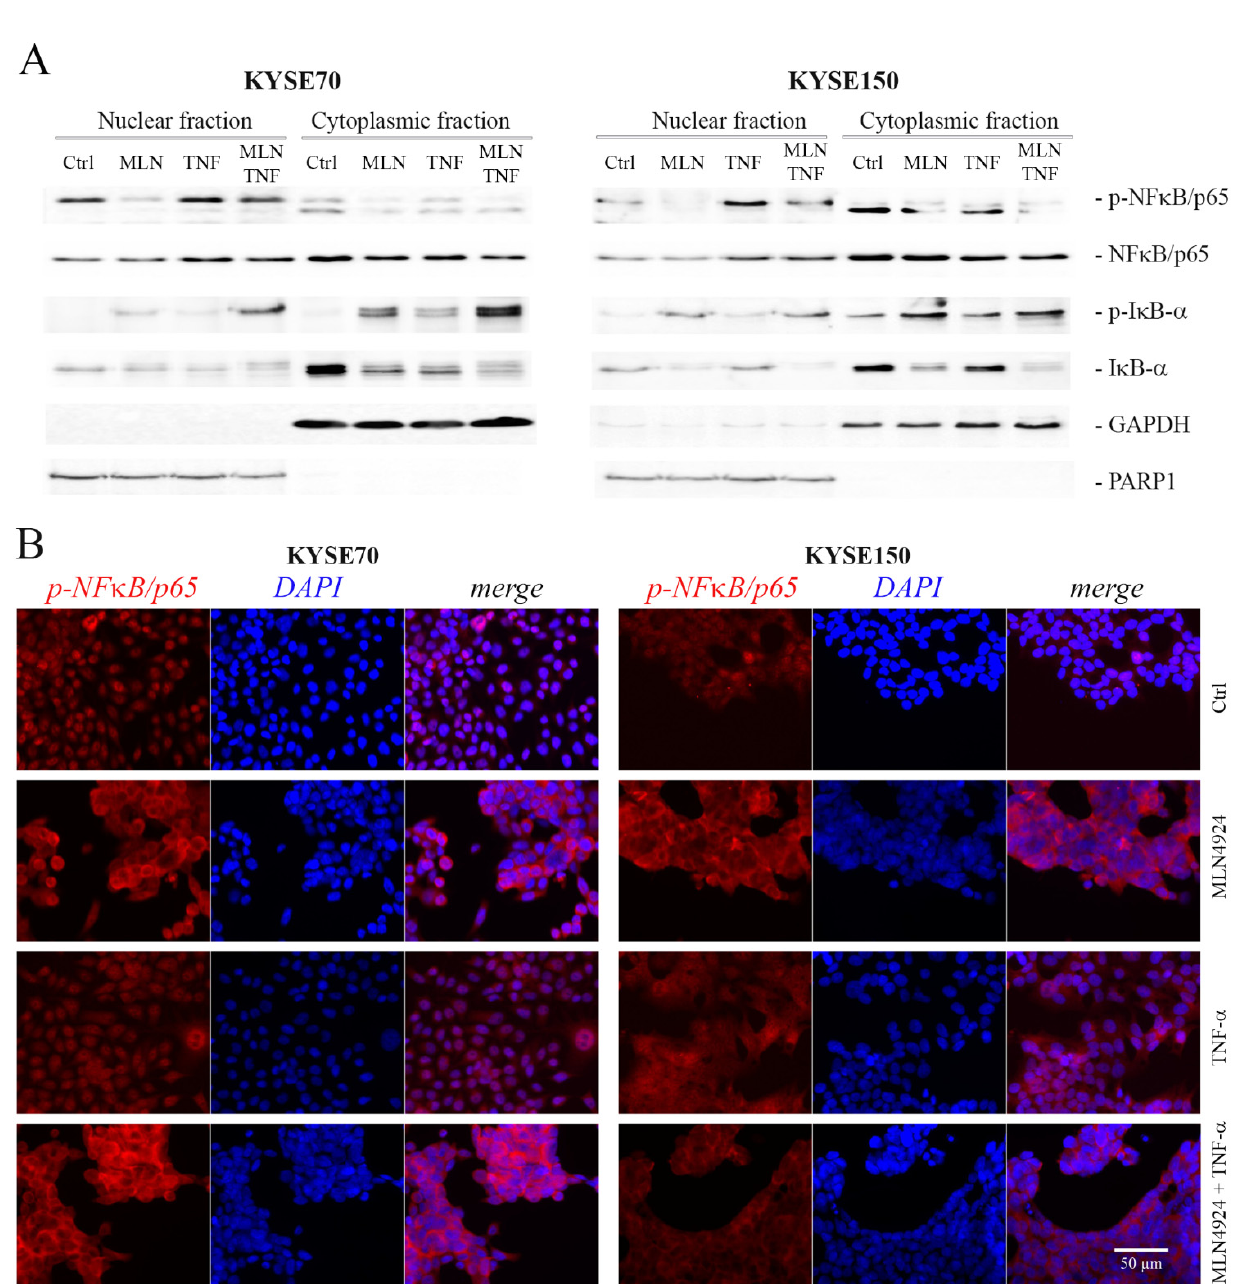
Figure 3. Subcellular localization of phospho-inhibitor of nuclear factor kappa B-alpha (phospho-I κ B- α ) and phospho- nuclear factor kappa B p65 subunit (phospho-NF κ B/p65) in KYSE70 and KYSE150 cells under treatment with tumor necrosis factor-alpha (TNF- α ) and MLN4924. ( A ) Western blot analysis of changes in cellular localization of phospho-I κ B- α (S32) and phospho-NF κ B/p65 (S536) in response to 24 h treatment with TNF- α (30 ng/mL) and MLN4924 (1 µM) applied separately or in combination. Protein cell lysates were separated into cytoplasmic and nuclear fractions which were probed for both total and phosphorylated forms of I κ B- α and NF κ B/p65. Glyceraldehyde 3-phosphate dehydrogenase (GAPDH)—cytosolic marker; Poly (ADP-ribose) polymerase 1 (PARP1)—nuclear marker. ( B ) Immunofluorescence staining showing subcellular localization of phospho-NF κ B /p65 (S536). Untreated KYSE150 and KYSE70 cells (Ctrl) or cells treated with MLN4924 (1 µM/24 h) or TNF- α (30 ng/mL/1 h) separately or in combination were fixed and probed against NF κ B/p65 phosphorylated at Ser536 (shown in red). The cell nuclei were additionally counterstained with DAPI (shown in blue). Unstimulated cells showed a weak signal from phospho-NFkB/p65, localized both to the cytoplasm and the nucleus. In the cells treated with TNF- α , phospho-NF κ B/p65 localized mostly to the nucleus. Phospho-NF κ B/p65 was predominantly localized to the cytoplasm in the presence of MLN4924.